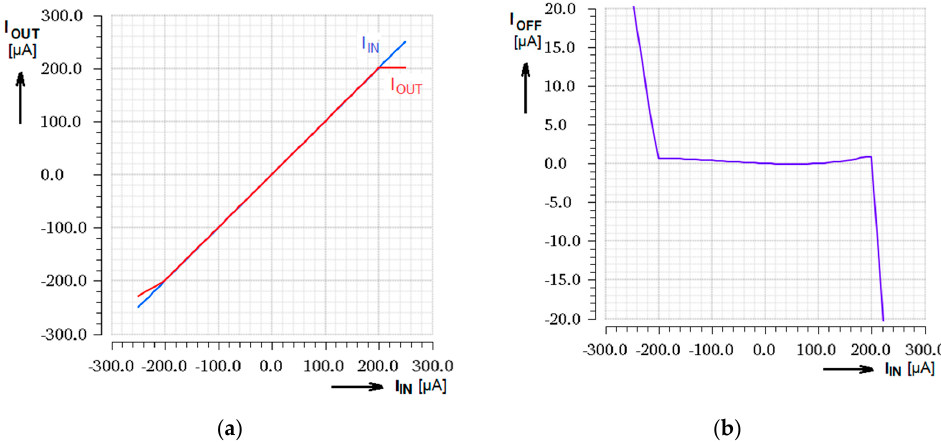
Figure 6. Simulated DC transfer response; ( a ) Input and output currents for amplifier gain B = 1; ( b ) Current input offset on input current dependence.